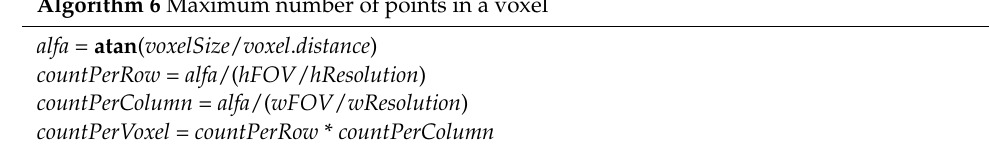
Algorithm 6 Maximum number of points in a voxel